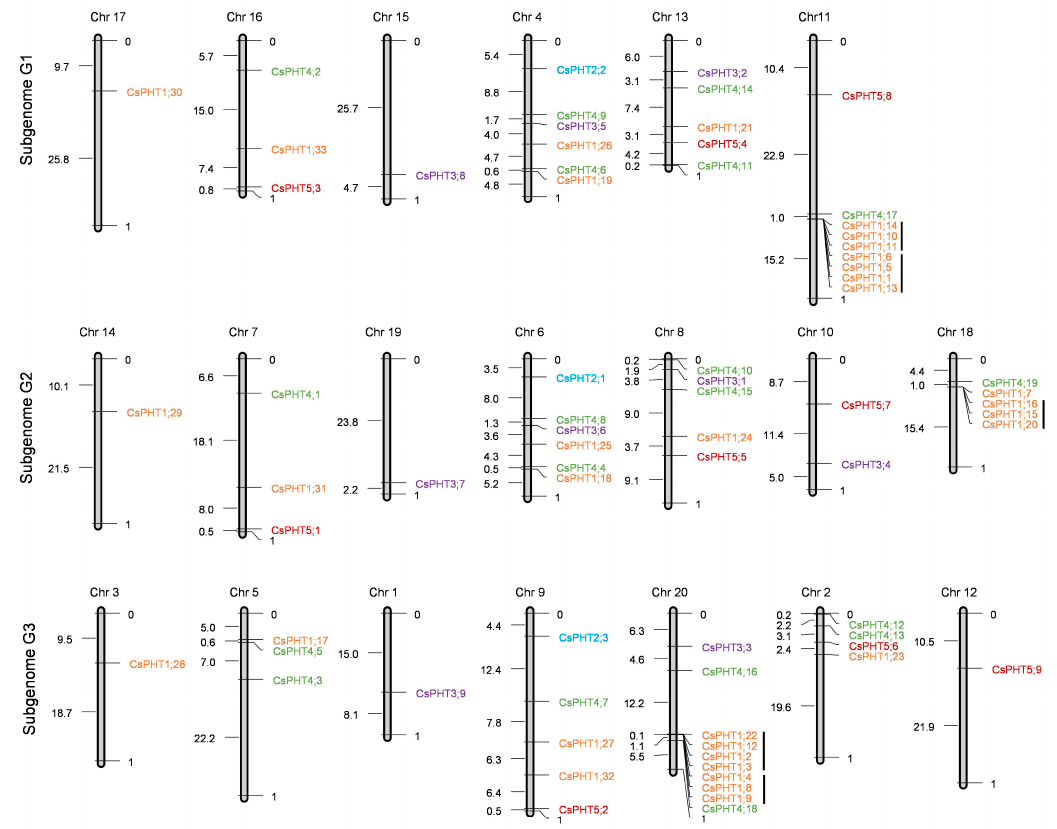
Figure 2. Chromosomal locations of CsPHT genes in the three sub-genomes. The genes were mapped using the MapDraw program [47]. Black lines next to the clustered genes represent tandem duplication